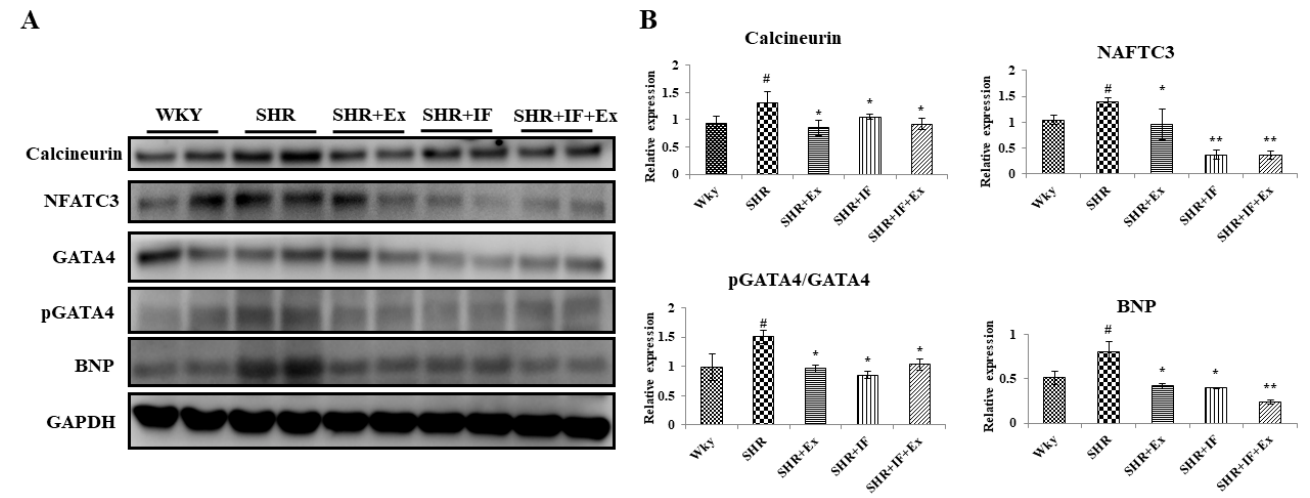
Figure 6. Role of IF peptide and exercise training in alleviating hypertrophy-related protein in hypertensive rats. ( A ) Expression of cardiac hypertrophy-associated markers: calcineurin, nuclear factor of activated T cells 3 (NFATC3), GATA binding protein 4 (GATA4), phosphorylated GATA4 (pGATA4), and brain natriuretic peptide (BNP) proteins. ( B ) Densitometric analysis of relative protein expression, normalized with internal control GAPDH, p-GATA4 is normalized with total GATA4. n = 8, # p < 0.01 compared to WKY, * p < 0.05, and ** p < 0.01 compared to SHR.